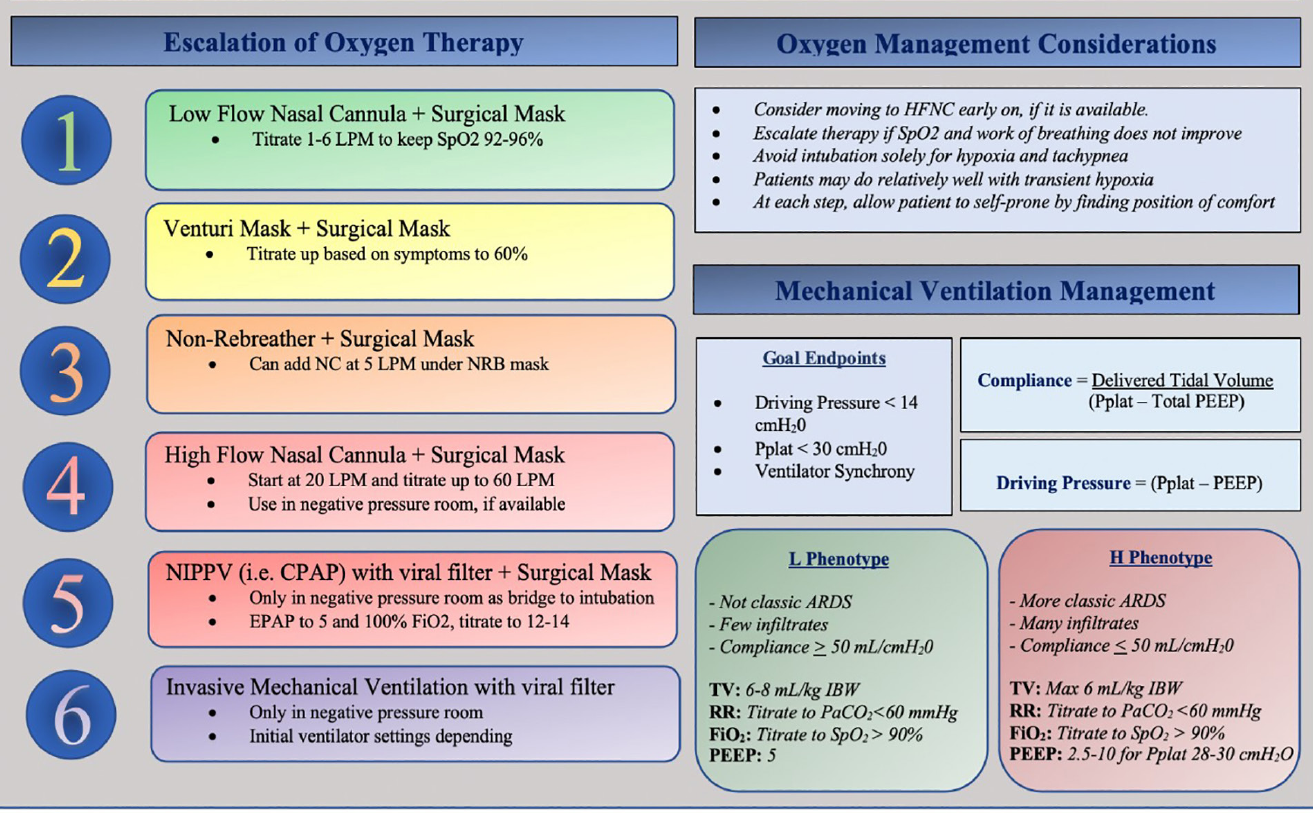
Figure 1. Respiratory management in coronavirus 2019 disease. LPM, liters per minute; NRB, non-rebreather mask; NIPPV, noninvasive positive pressure ventilation; CPAP , continuous positive airway pressure; EPAP, expiratory positive airway pressure; SpO , peripheral capillary oxygen saturation; RR, respiratory rate; Pplat, plateau 2 pressure; PEEP, positive end-expiratory